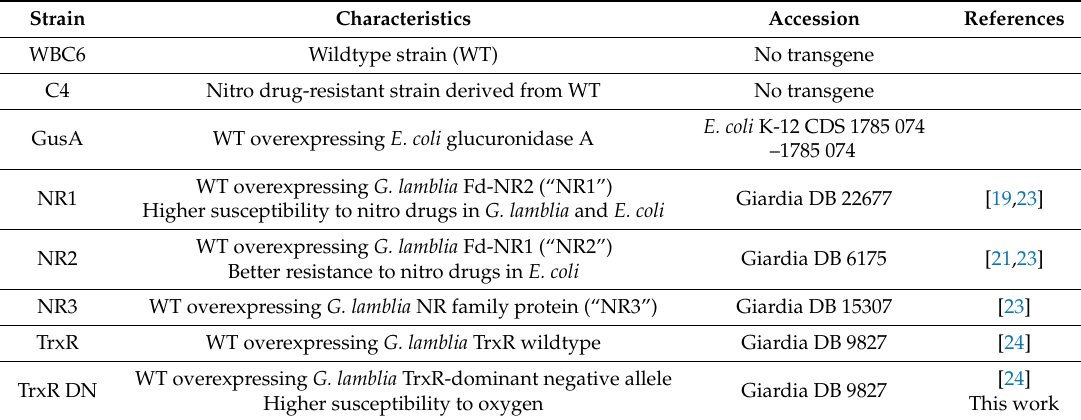
Table 1. List of the transgenic Giardia lamblia strains used in this study. All transgenes were fused to the strong, constitutive arginine deiminase (ADI)-promotor. CDS, coding sequence; NR, nitroreductase; TrxR, thioredoxin reductase; TrxR DN, dominant negative mutation of TrxR. Please note that we have kept our original designations NR1, NR2, and NR3 to be in frame with our previous